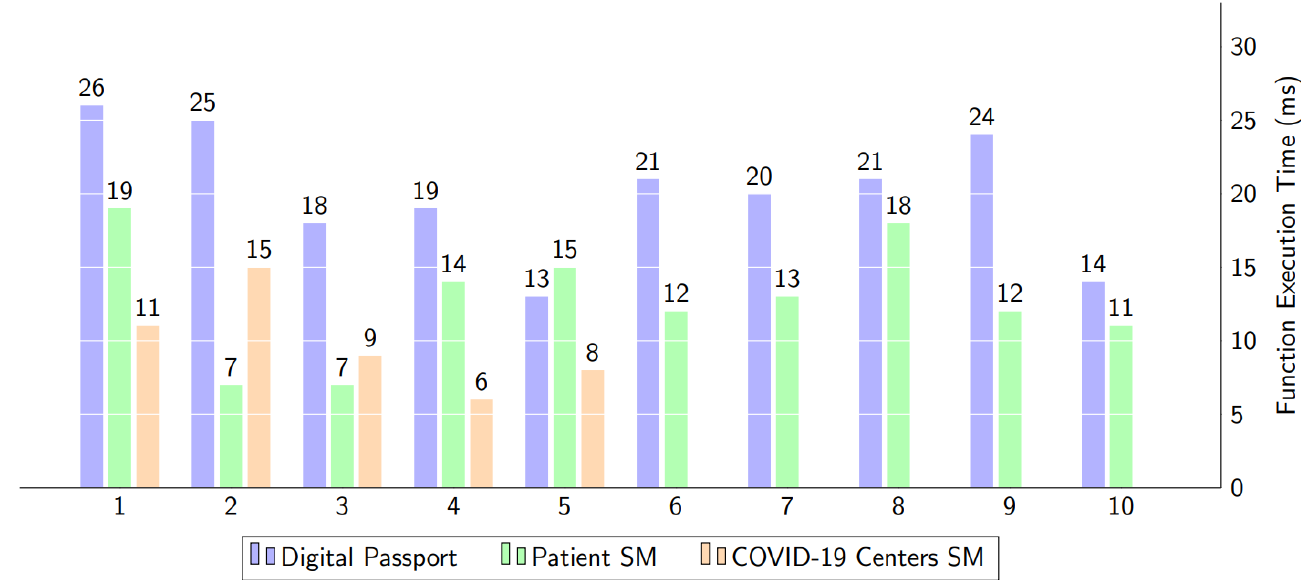
Figure 12. The computational time for data storage in IPFS and Blockchain via function execution.